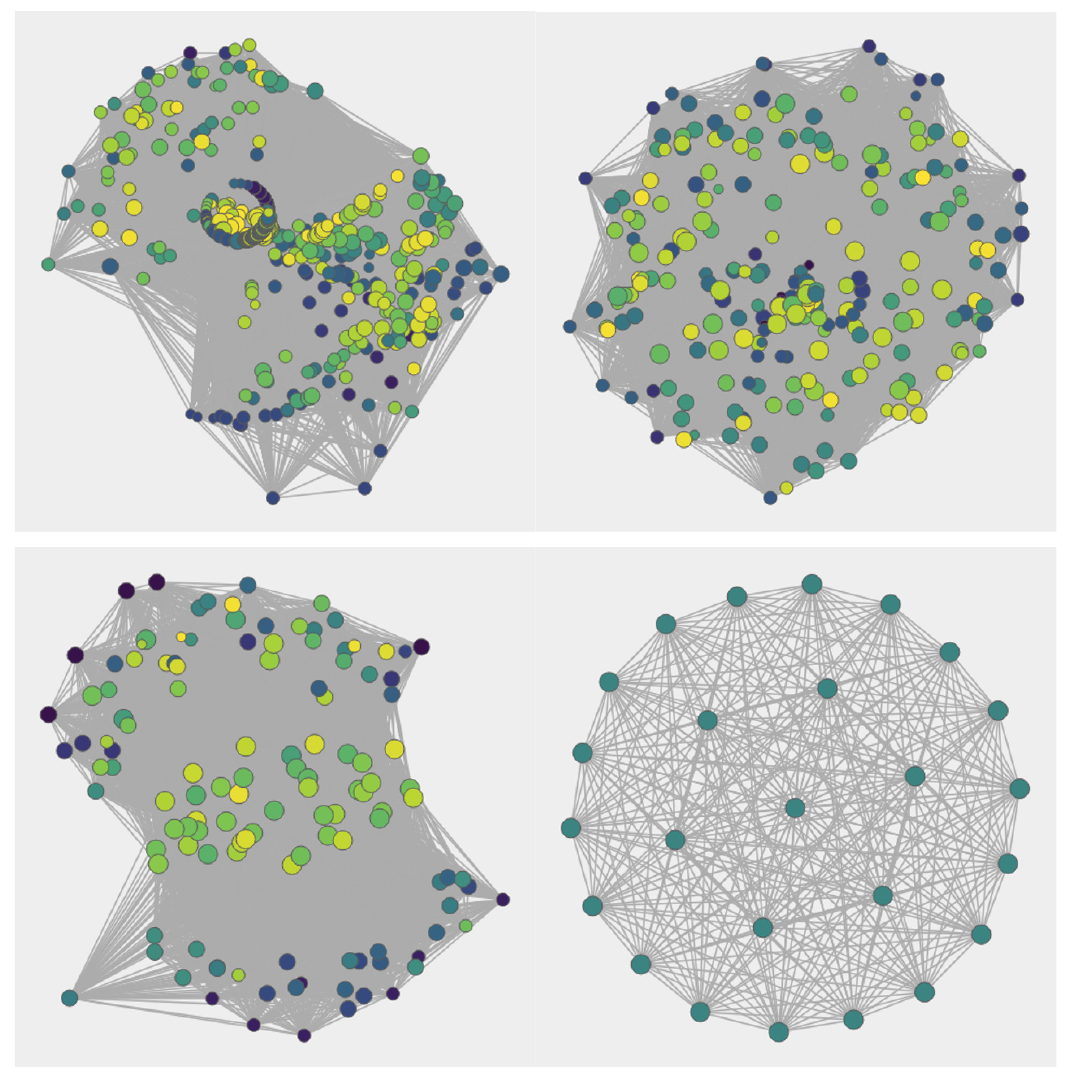
Figure 5. Continuous homology process, the time sequence is: top left (1), top right (2), bottom left (3), bottom right (4).